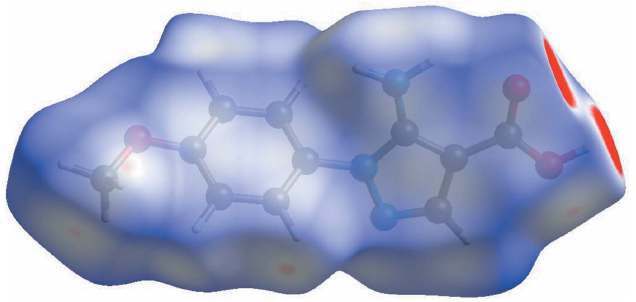
Figure 5 Hirshfeld surface for (I) mapped over d norm